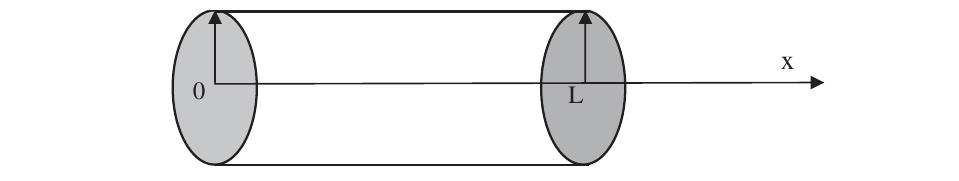
FIG. 3 (color online). Resistor